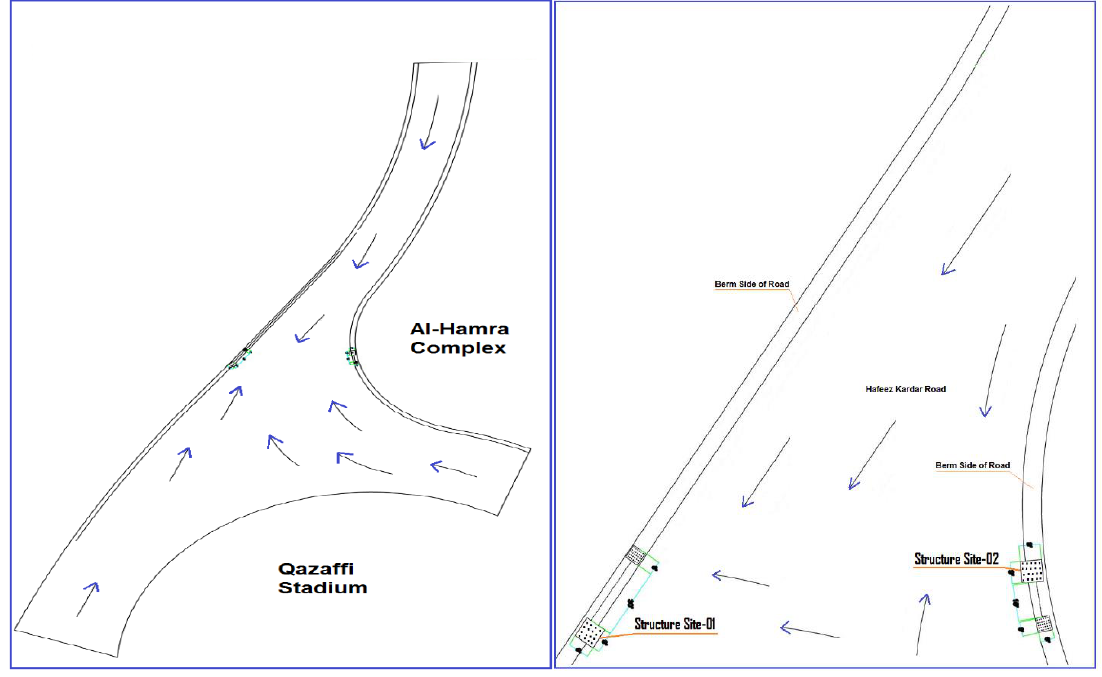
Figure 15. Layout view of recharge well construction site.